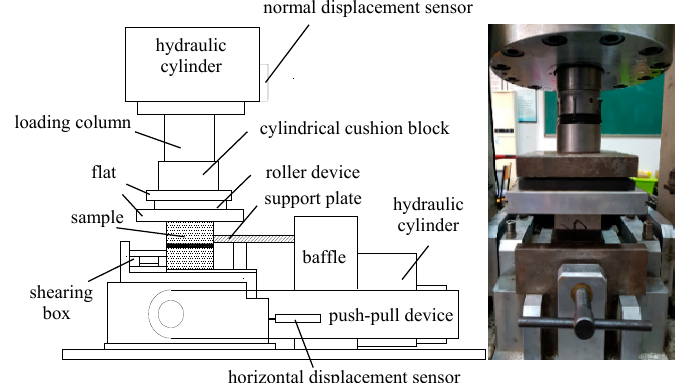
Figure 5. The test system of shearing loading of RMT-150B. Table 2. The shearing experiment scheme.